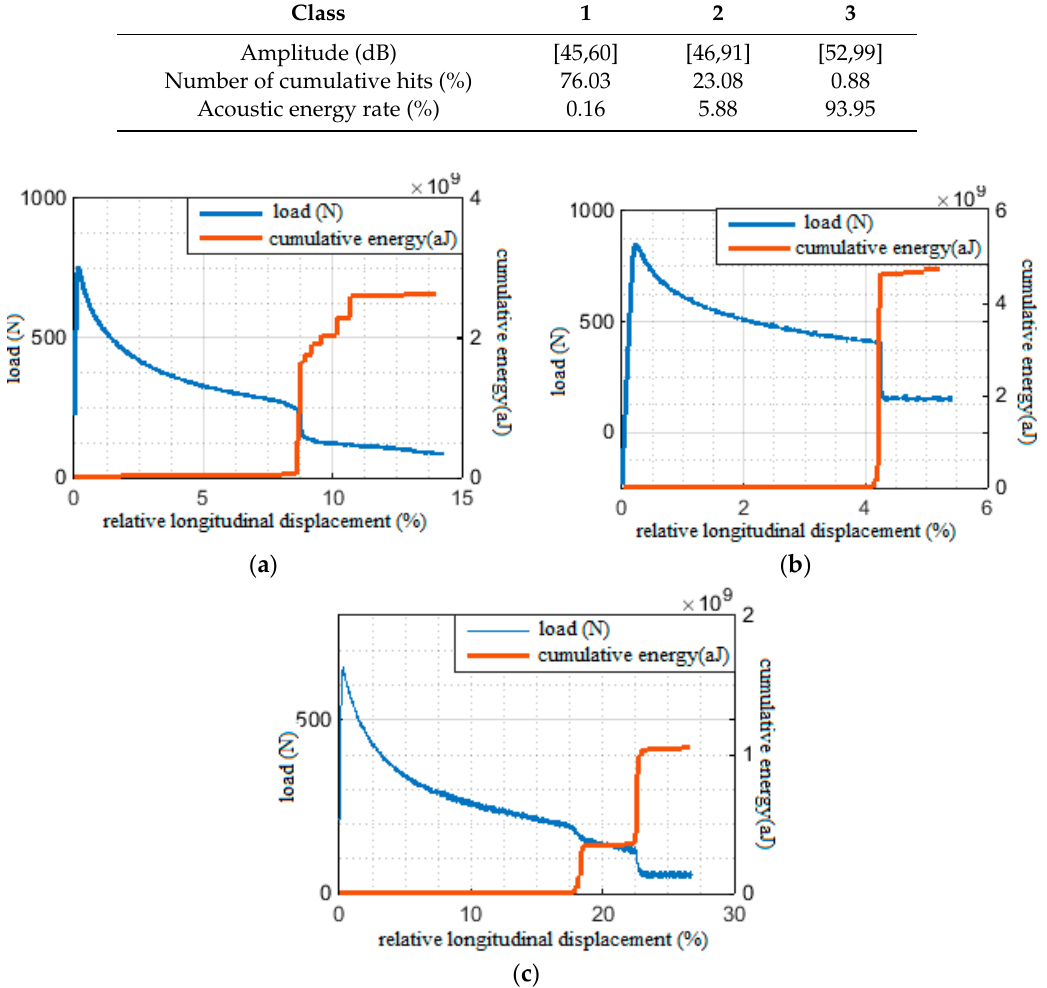
Figure 15. Simultaneous evolution of the load and cumulative acoustic energy of ( a ) 0 ◦ specimens, ( b ) 90 ◦ specimens, ( c ) 45 ◦ specimens.